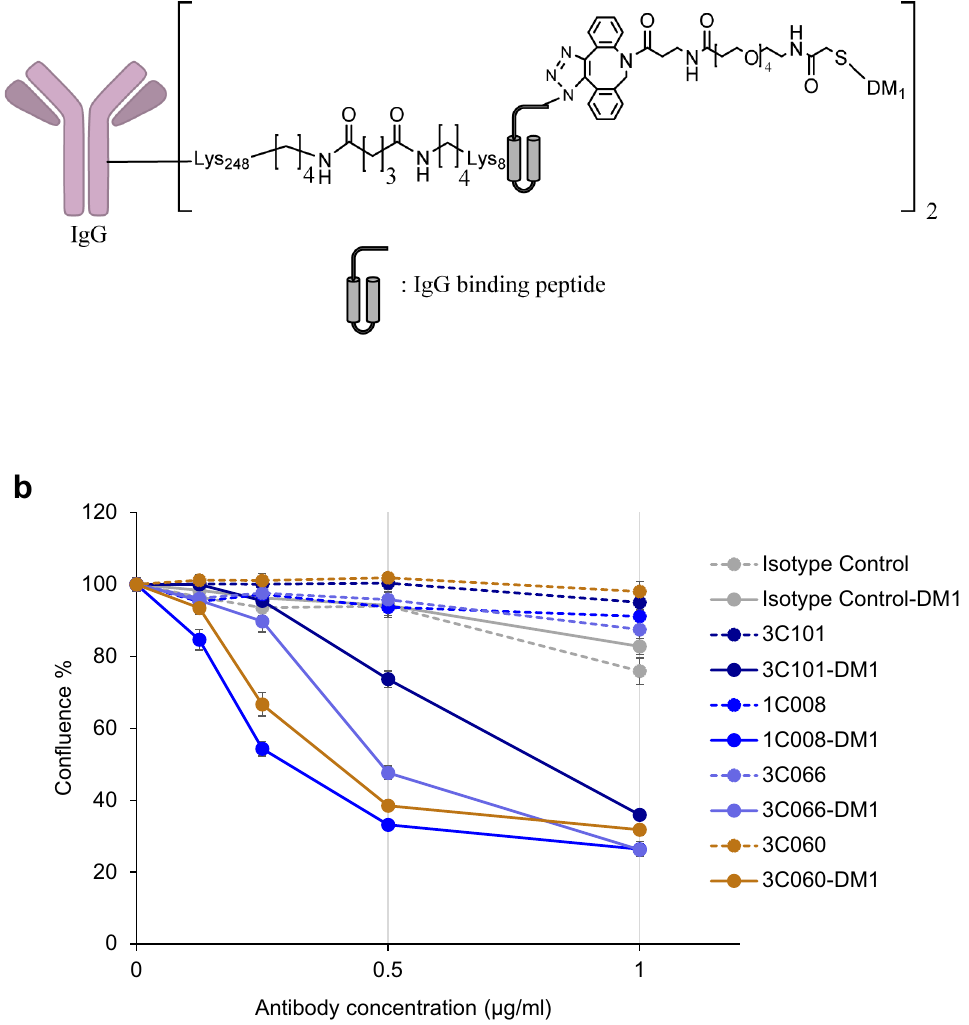
Figure 6. Cytotoxicity of antibody–drug conjugate. ( a ) Schematic design of mAb-IgG-BP-DM1. The selected monoclonal antibody (mAb) was modified with azide-attached chemical conjugation by affinity peptide reagent and labeled with mertansine (DM1) via mixing with DBCO-PEG4-DM1. ( b ) Cytotoxicity of anti-EpCAM mAbs directly labeled with DM1 using the CCAP method. The growth of HCT116 cells was monitored as the percentage confluence. The percentages at 60 h are indicated (n = 3). Data are presented as the mean ±